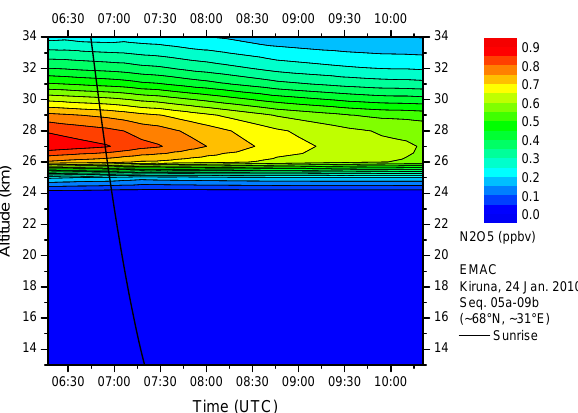
Fig. 14. Temporal evolution of N 2 O 5 mixing ratios as calculated by EMAC.